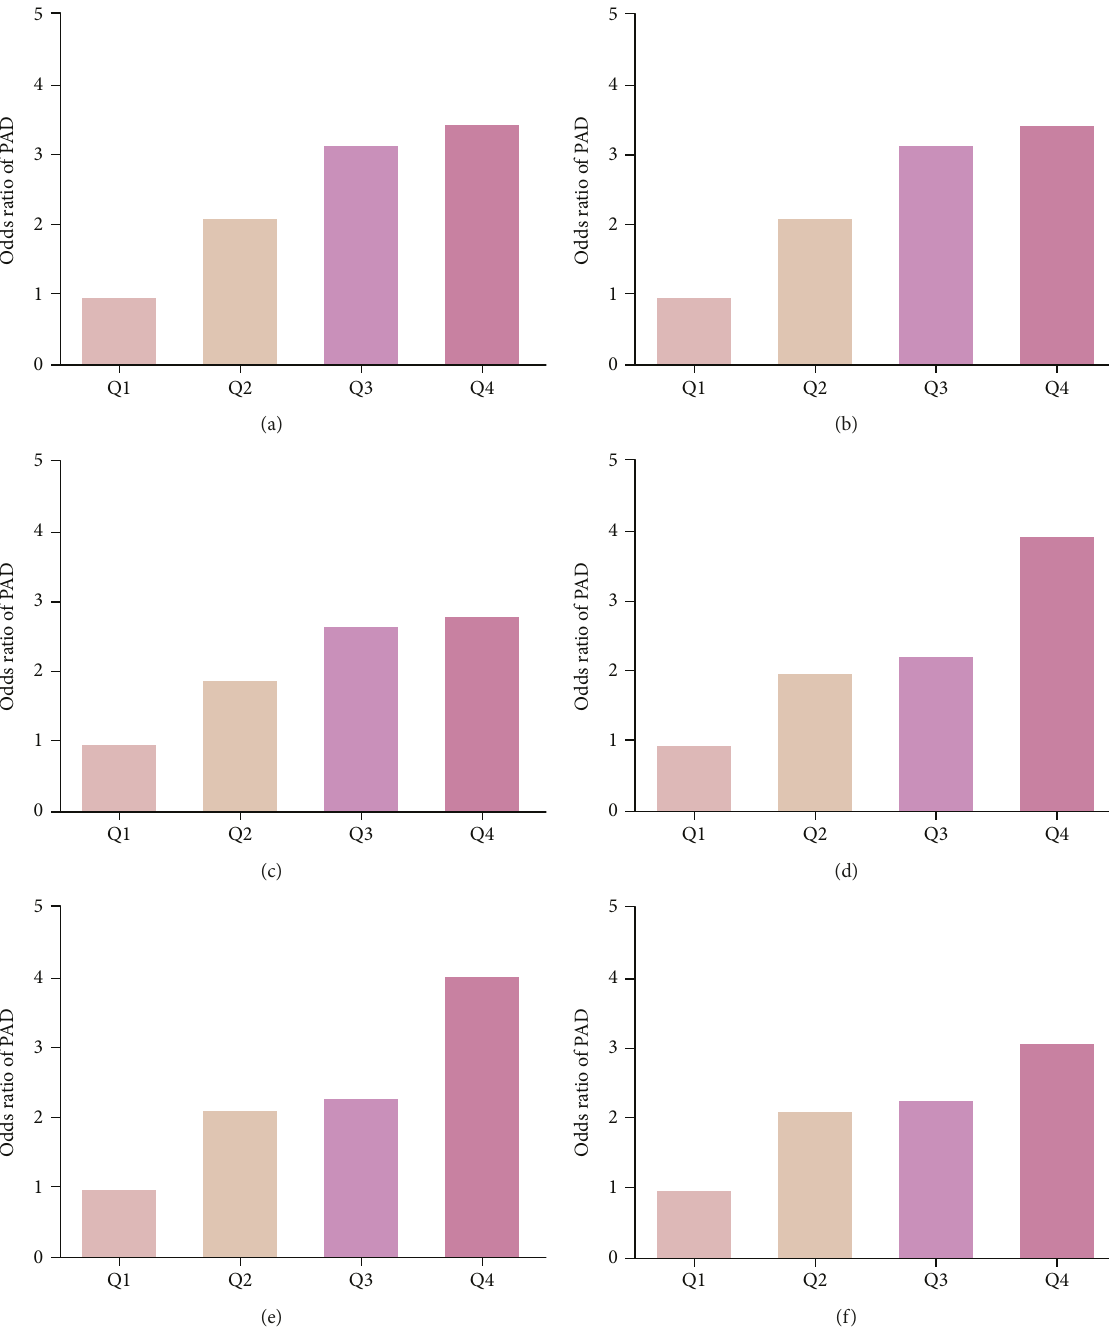
Figure 1: Unadjusted and adjusted odds ratios (ORs) for quartiles of serum fi brinogen in population, strati fi ed by sex: (a-c) male and (d-f) female. Panels (a) and (d) are univariate analysis for fi brinogen; panels (b) and (e) are adjusted for age; panels (c) and (f) are adjusted for age, hypertension, weight, BMI, waist circumference, hip circumference, TC, HDL-C, and HbA1c. All of the P values are less than